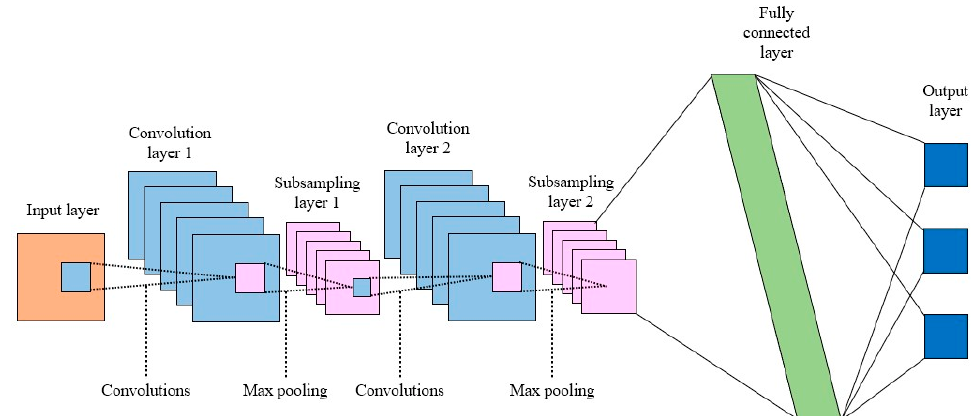
Figure 8. Convolutional neural network architecture.